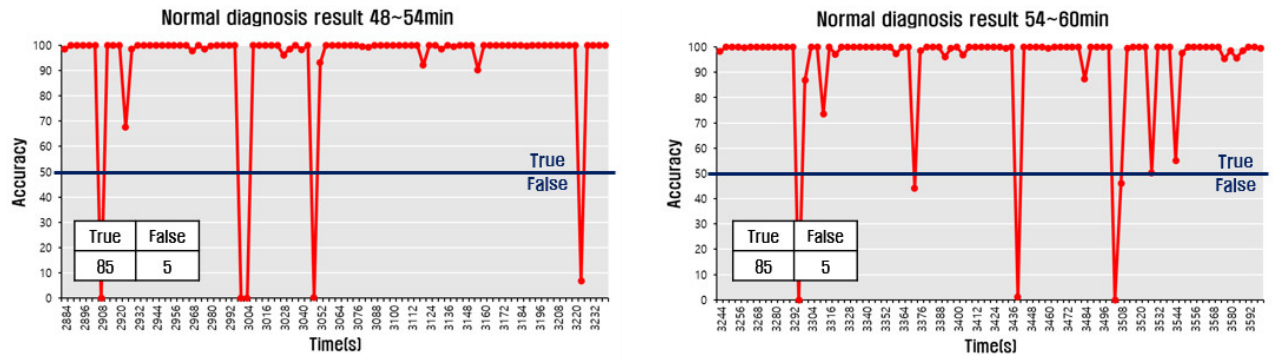
Figure 16. Test result with normal sound for 0~60 min.